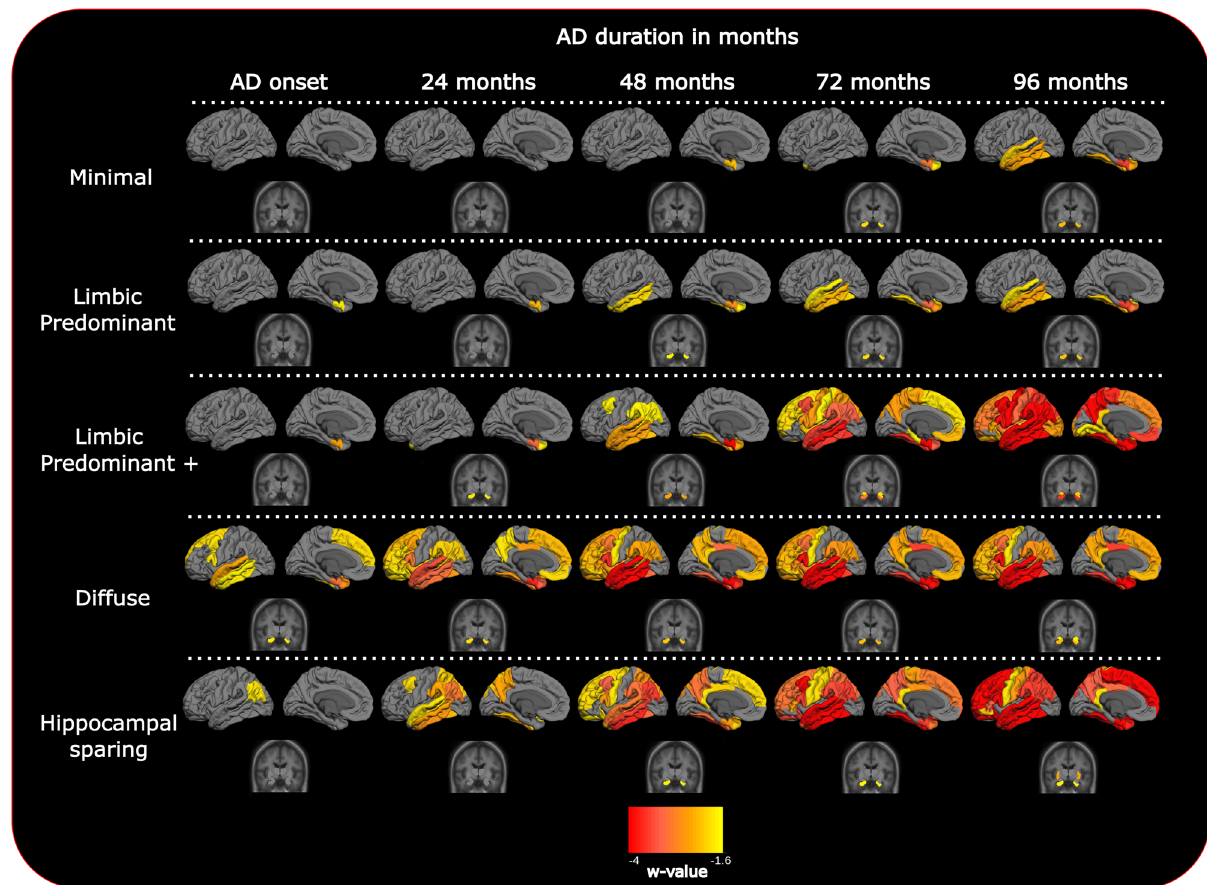
Fig. 2 | Fitted values for cortical thickness and subcortical volumes for the different longitudinalpatternsofatrophyfromAD onset. Atrophy- fi tted values from clinical AD onset. Each row represents one cluster of patients with the cor- responding pattern of atrophy. The color scale illustrates cortical thinning and subcortical volume loss compared to A β negative, cognitively unimpaired (CU)